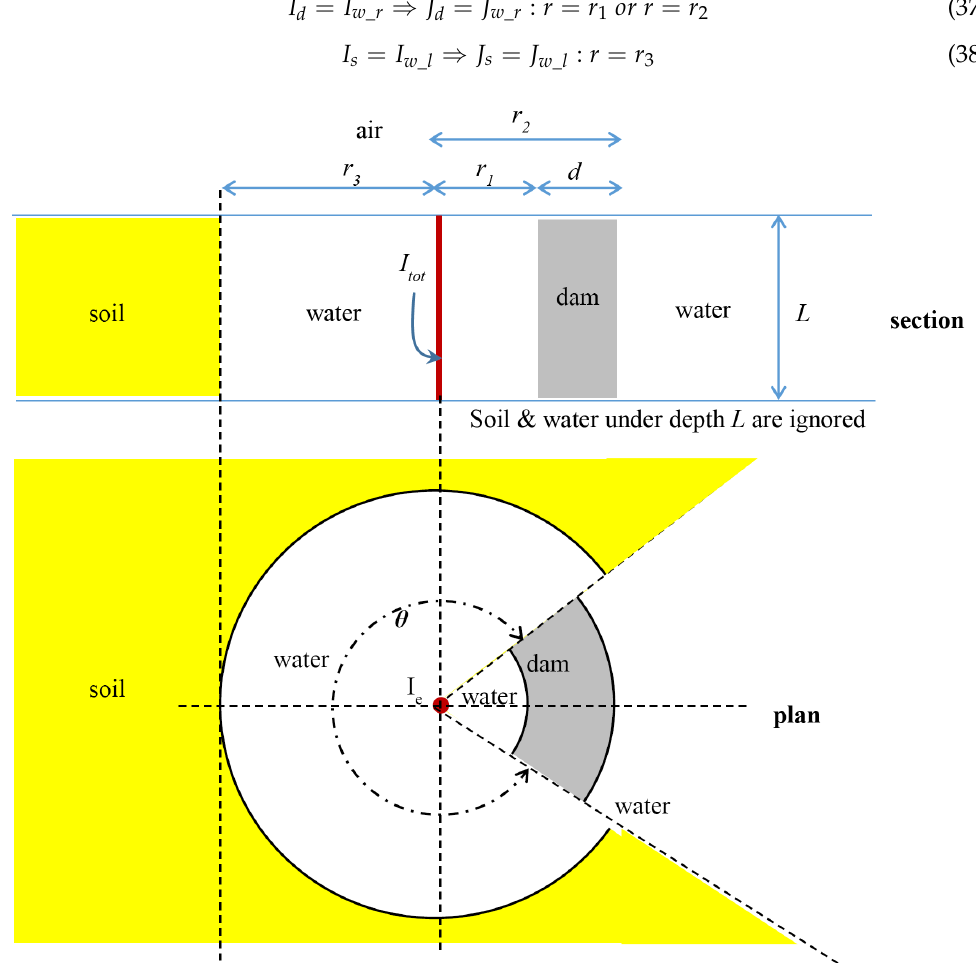
Figure 6. Simplified model for placement of an electrode on the shore or in near-shore sea considering a linear electrode, in cylindrical coordinates and using a dam–soil